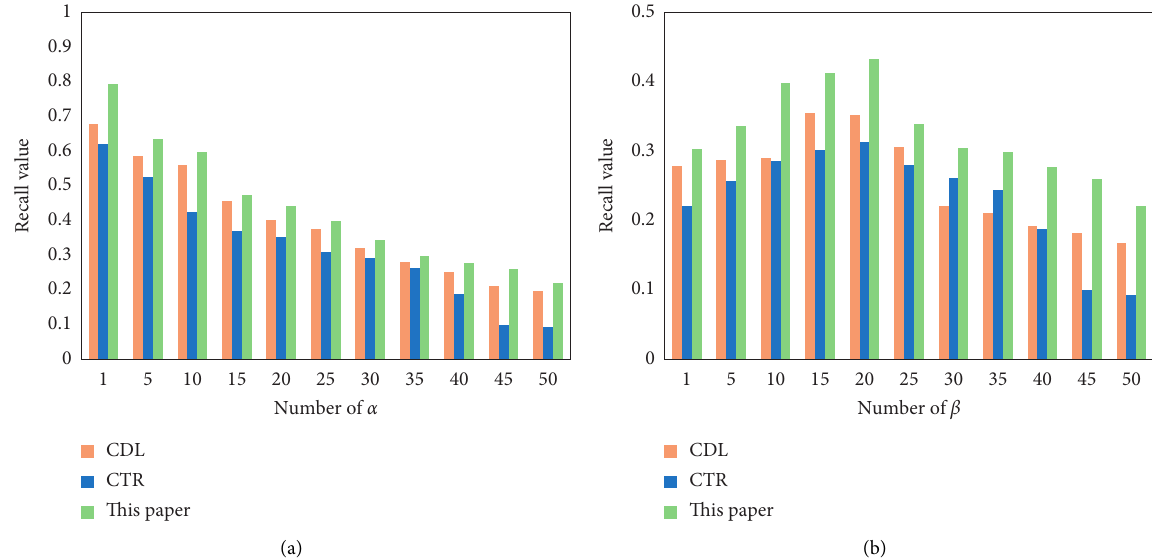
Figure 4: The effect of α and β on recommended performance. (a) Impact of α on recommended performance. (b) Impact of β on recommended